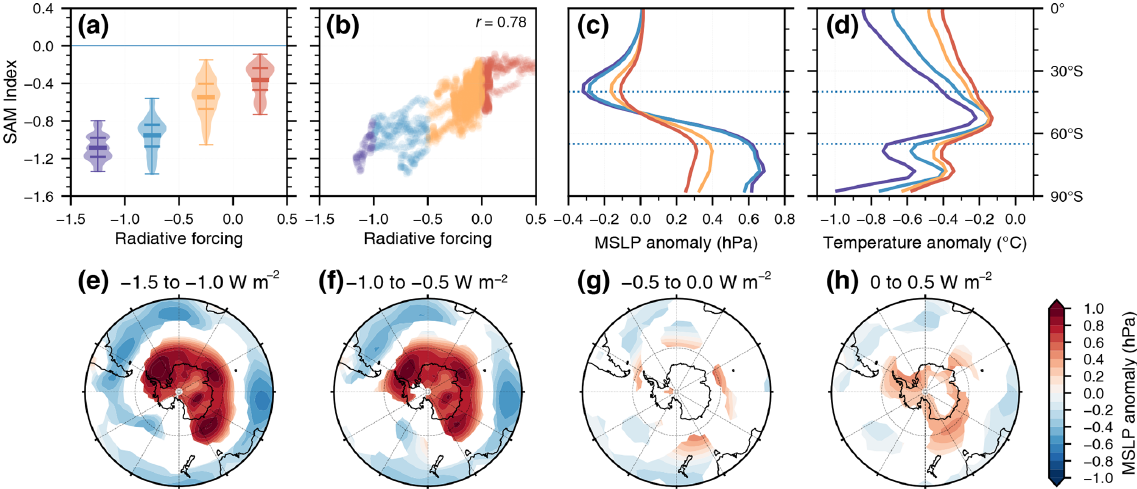
Figure 9. SAM index response to different levels of radiative forcing compiled across solar transient experiments. (a) Violin plots of the 70-year rolling mean SAM index between 850 and 1900CE; lines refer to the 25th percentile, mean, and 75th percentile. (b) Scatter plot of 70-year rolling mean for radiative forcing anomaly and the SAM index where r = 0 . 78 ( P < 0 . 05). (c–d) Zonal mean anomalies for (c) mean sea level pressure (MSLP) and (d) temperature, where the anomaly is relative to the climatological (1900–1999CE) mean. Coloured lines refer to the radiative forcing bins for − 1 . 5 to − 1 . 0Wm − 2 (purple), − 1 . 0 to − 0 . 5Wm − 2 (blue), − 0 . 5 to 0.0Wm − 2 (orange), and 0.0 to 0.5Wm − 2 (red). (e–h) MSLP anomalies (relative to the climatological mean based on radiative forcing bins). Regions shown are significantly different to the OGS ensemble mean (based on Welch’s t test, P < 0 . 05); areas where P ≥ 0 . 05 have been masked out. Dashed lines at 40 and 65 ◦ S are the latitudes used to calculate the SAM